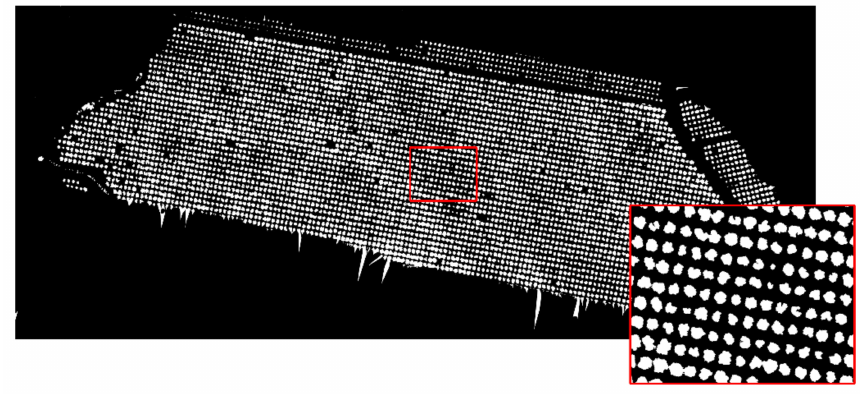
Figure 8. Image I BIN 1 resulting from the binarization of I GS 3 , shown in Figure 6c. Note in the zoomed area, in the red square, how potential plants have been accurately segmented from the